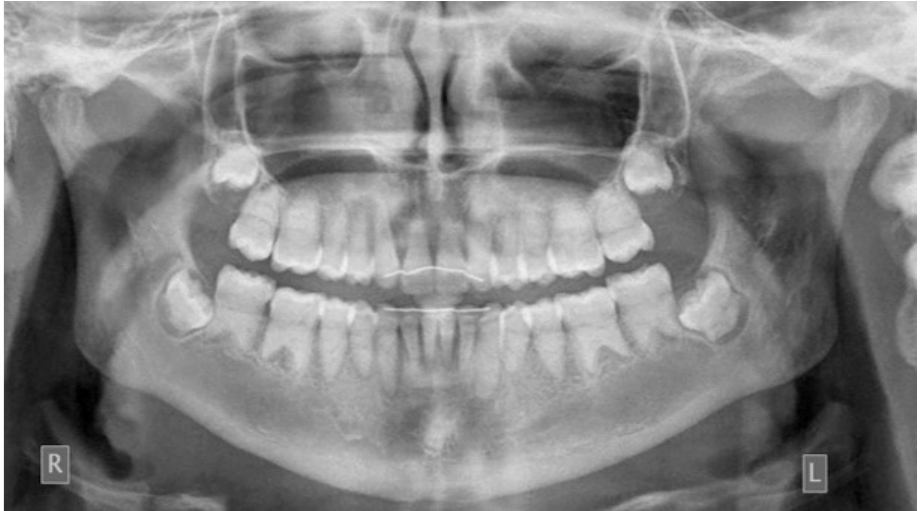
Figure 11. Post-treatment panoramic radiograph. No root resorption was observed (R: right, L: left).